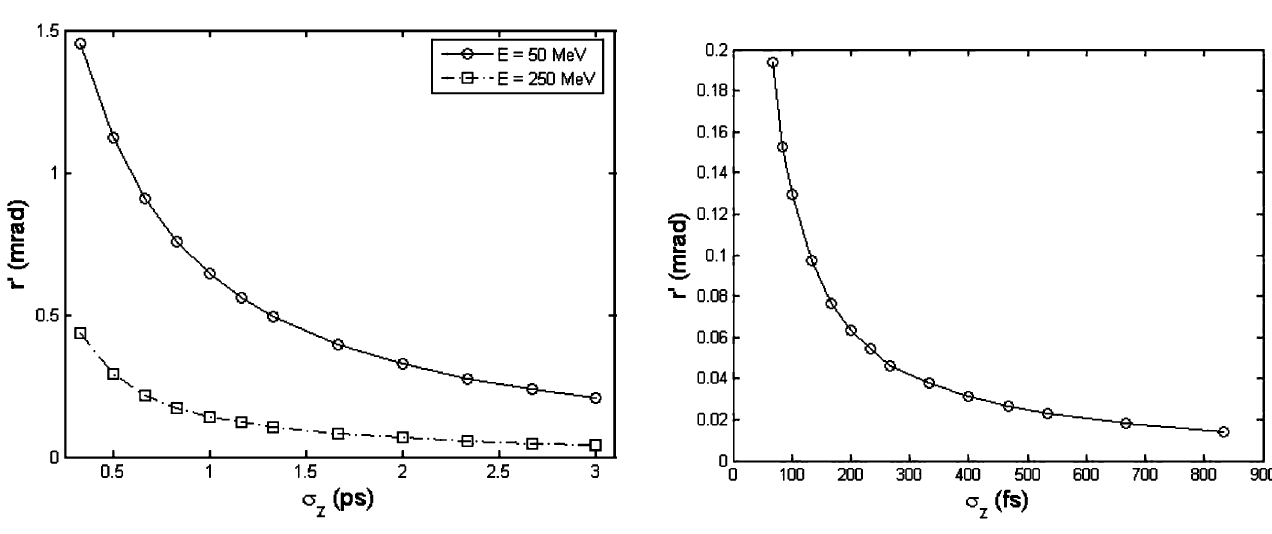
FIG. 2. DR Deflection of medium-energy electron beam with various bunch length.